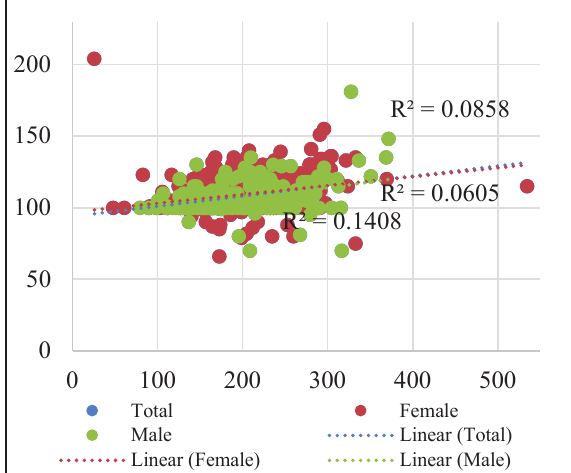
Fig-2 : Correlation between device method and laboratory method according to gender